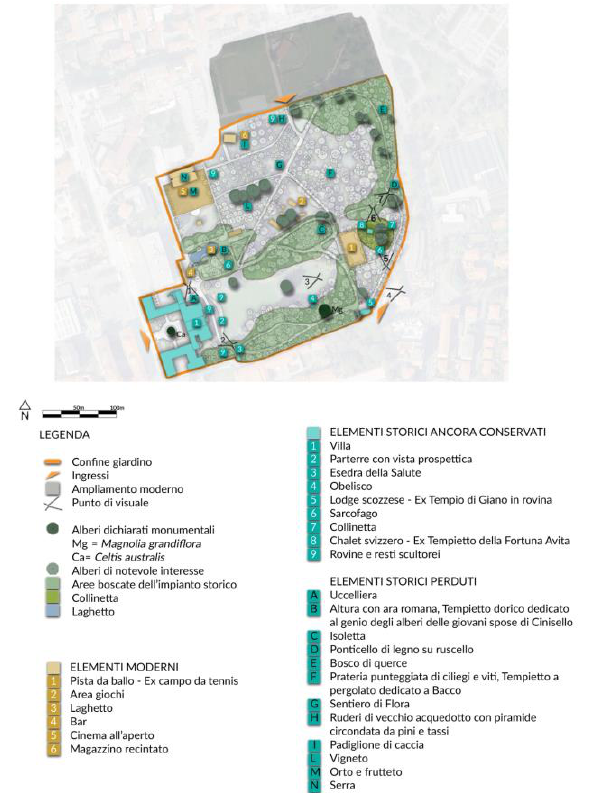
Figure 1. Analysis of historic and modern elements of Villa Ghirlanda Silva historic public garden in Cinisello Balsamo (Milan Province).